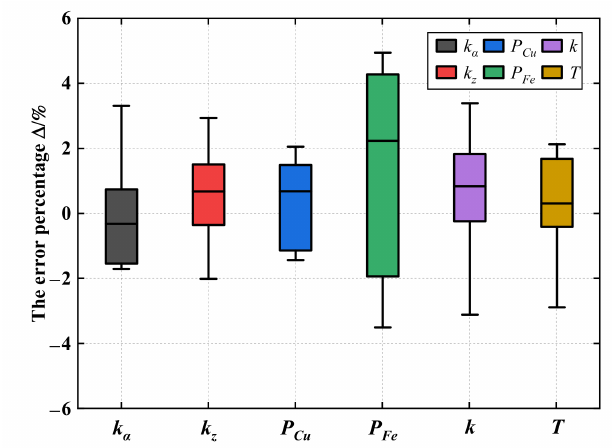
Figure 7. The error percentage of the optimized performance of the test